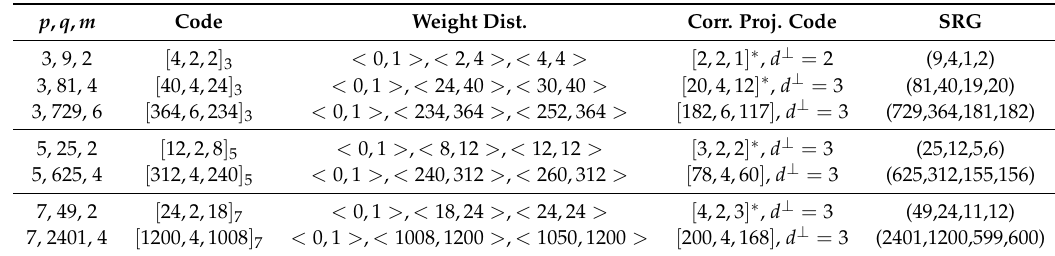
Table 1. Two-weight trace codes from nonzero squares.